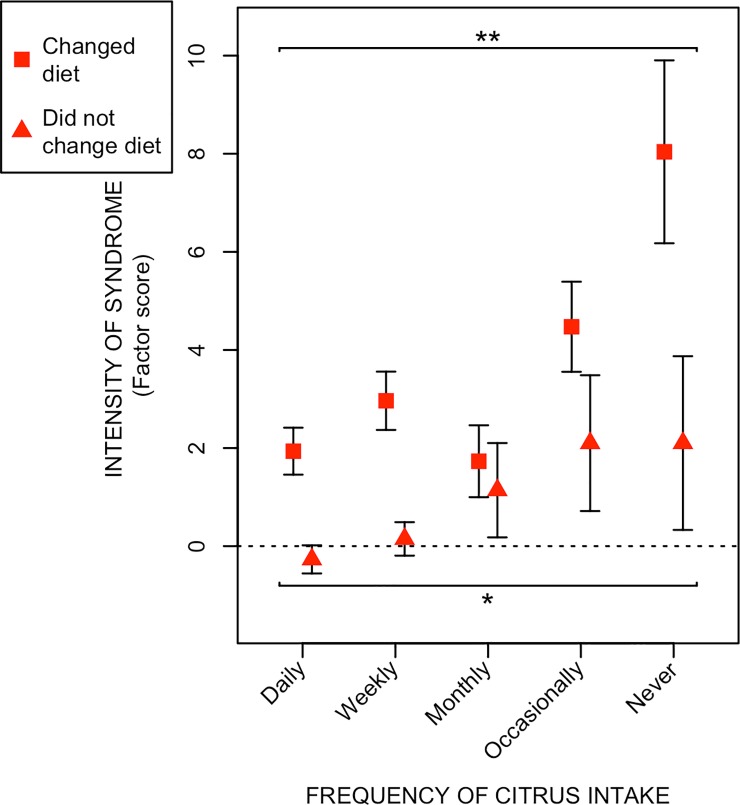
Relationship between radiation-induced defecation-urgency syndrome and frequency of citrus fruit intake, stratified by those who have changed and those who have not changed dietary behavior after radiotherapy.The figure depicts the relationship between frequency of citrus fruit intake (x-axis) and the intensity (factor scores) the defecation-urgency syndrome (y-axis) among long-term gynecological cancer survivors stratified according to having or not having made dietary changes after receiving radiotherapy (see the Methods section for detailed information). Red squares and green triangles denote the mean intensities of the syndromes within certain citrus intake frequency levels. Vertical black lines stretch between plus-minus the standard error of the mean. Asterisks correspond to significance levels of the Spearman correlations between syndrome intensity and frequency of citrus intake according to: p ≤ 0.001 - ***, 0.001 < p ≤ 0.01 - **. 0.01 < p ≤ 0.05 - *.